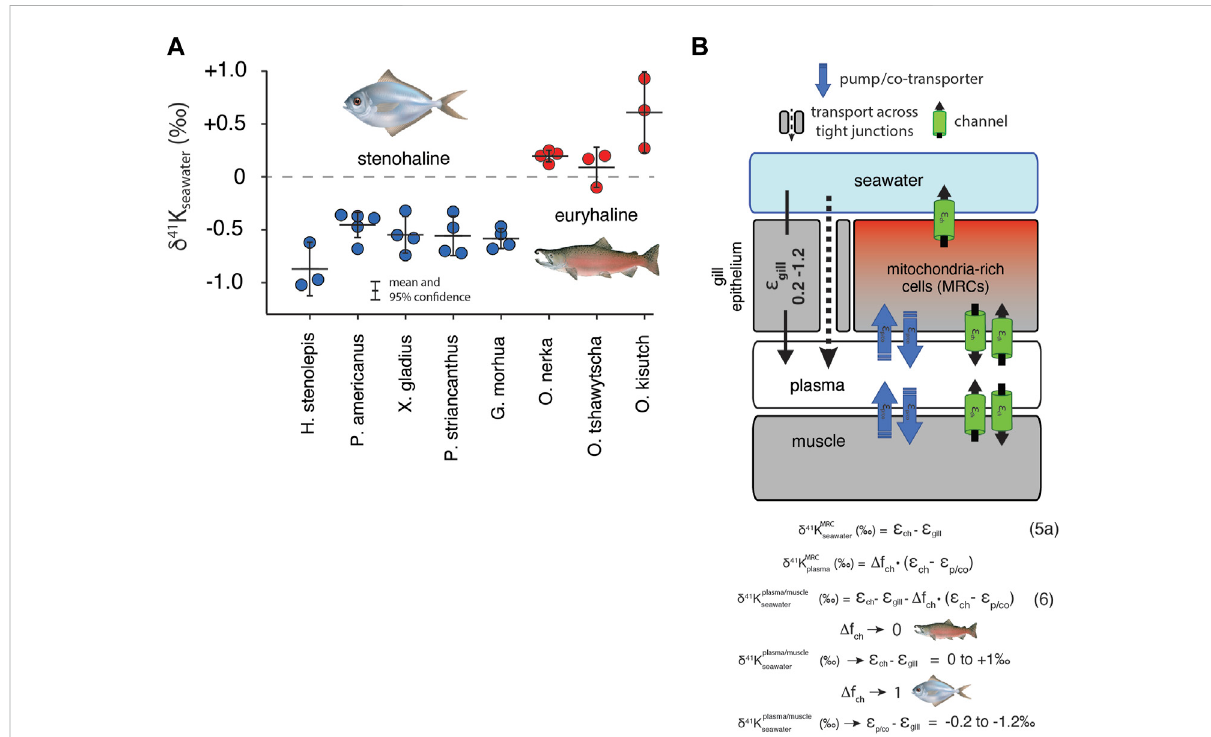
FIGURE 5 (A) The difference in δ 41 K values between seawater and dorsal white muscle of various stenohaline and euryhaline marine fi sh. Muscle [K + ] and δ 41 K − 10 for the difference in δ 41 K seawater values are listed in Supplementary Table S1. p = 1.4 × 10 seawater value between stenohaline and euryhaline teleosts. (B) A model of K isotope mass balance in a marine fi sh. K + is supplied across the gill epithelium via transport through pores in tight-junction proteins and lost from mitochondria-rich cells (MRCs) through channels Eq. 5. K + cycling within MRCs is modeled using Eq. 3. Combining Eq. 3 and Eq. 5a yields Eq. 6, the δ 41 K value of plasma/muscle relative to seawater as a funciton of ε ch , ε gill , Δ f ch of MRC ’ s and ε p/co . As Δ f ch → 0, δ 41 K of fi sh muscle → ε ch - ε gill ( ≥ 0 ‰ , euryhaline), whereas as Δ f ch → 0, δ 41 K of fi sh muscle → ε p/co - ε gill ( < 0 ‰ , stenohaline). fi sh illustrations from Lori